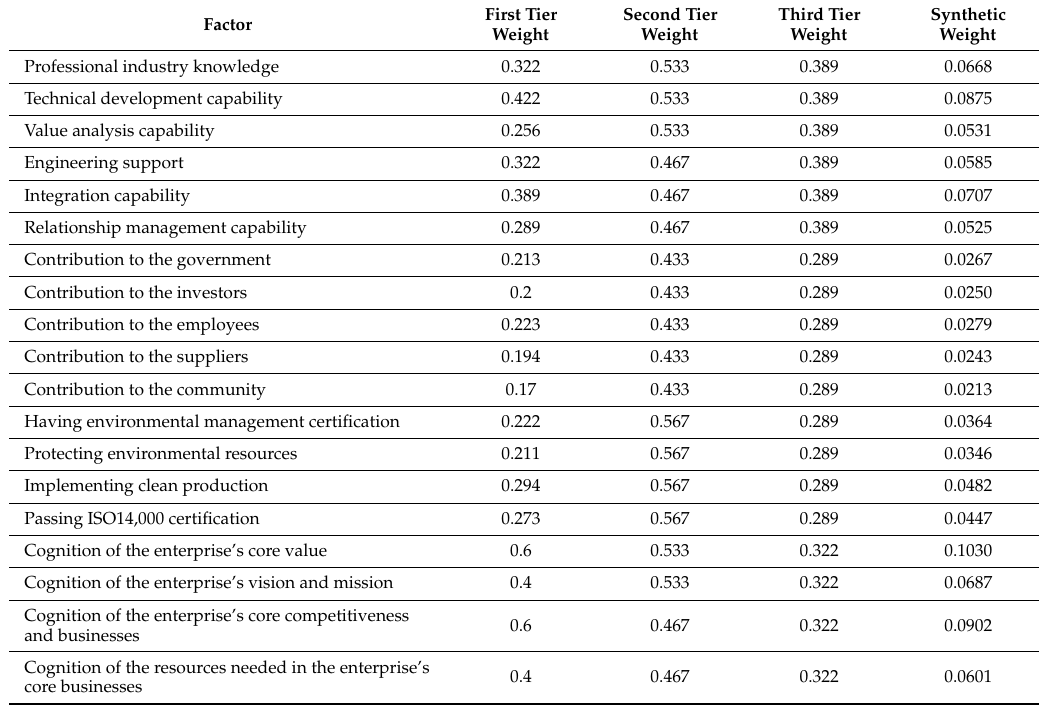
Table 9. Weights of